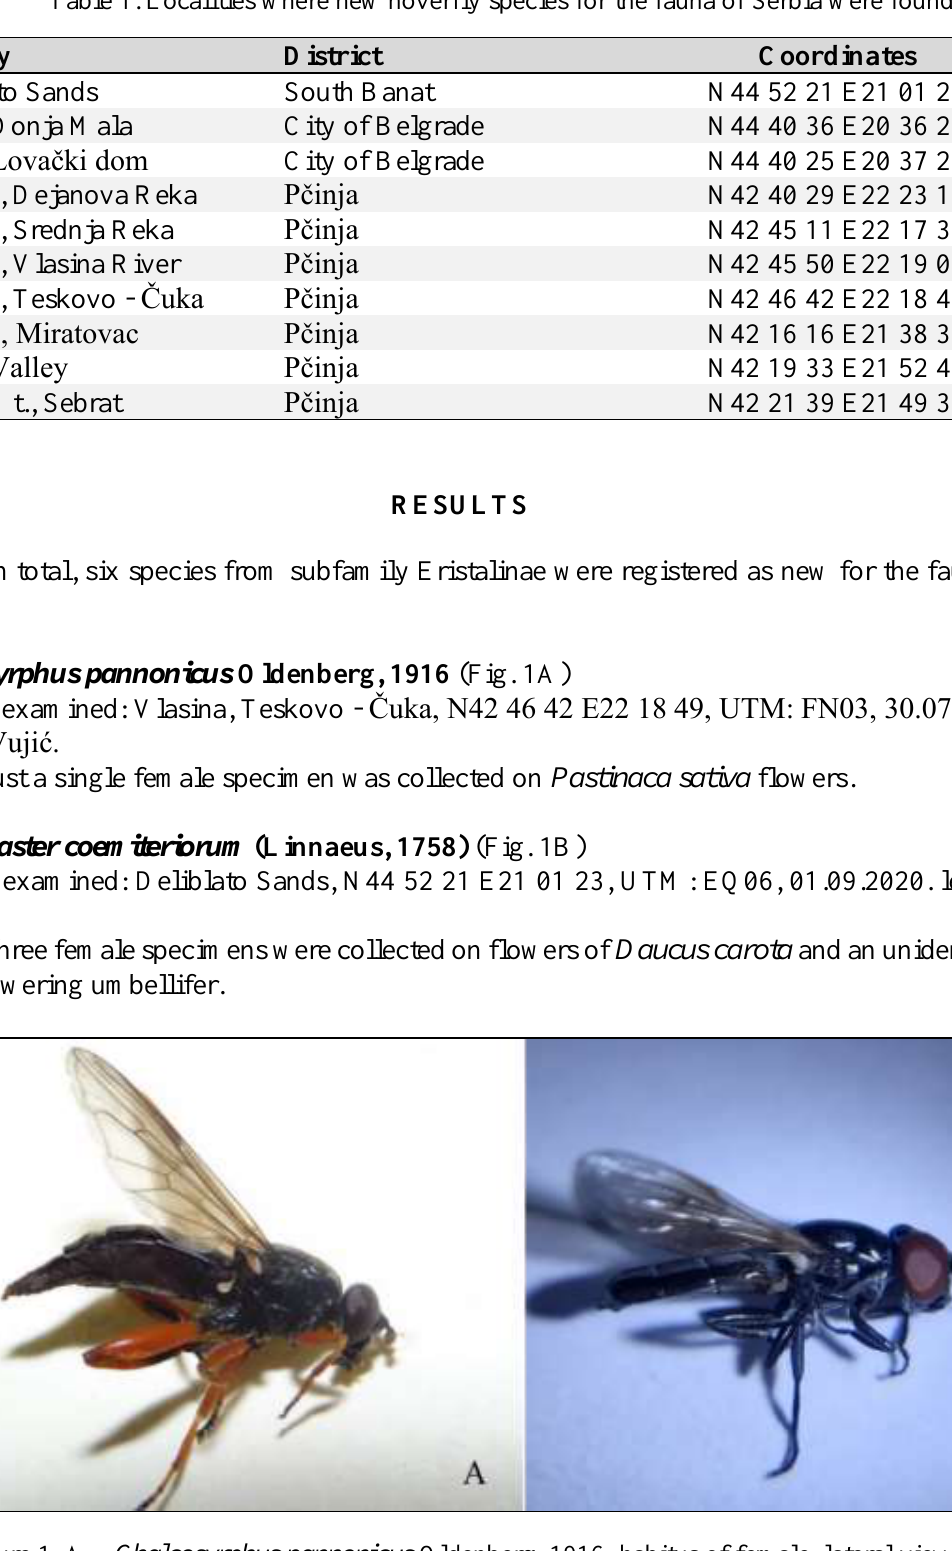
Figure 1. A − Chalcosyrphus pannonicus Oldenberg, 1916: habitus of female, lateral view; B − Chrysogaster coemiteriorum (Linnaeus, 1758): habitus of female, lateral view. (Photos: M. Vujić,